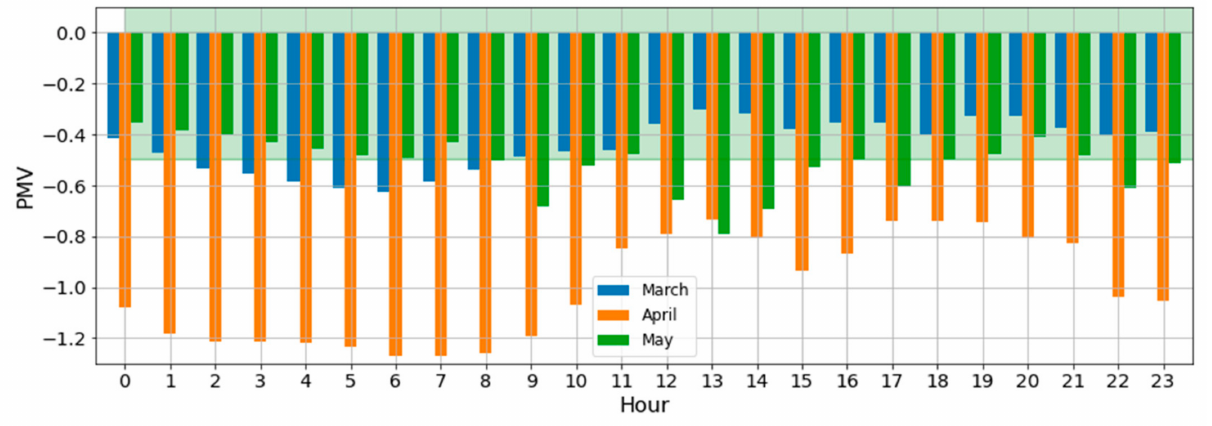
Figure 13. Average monthly PMV distribution over the day—March, April and May.